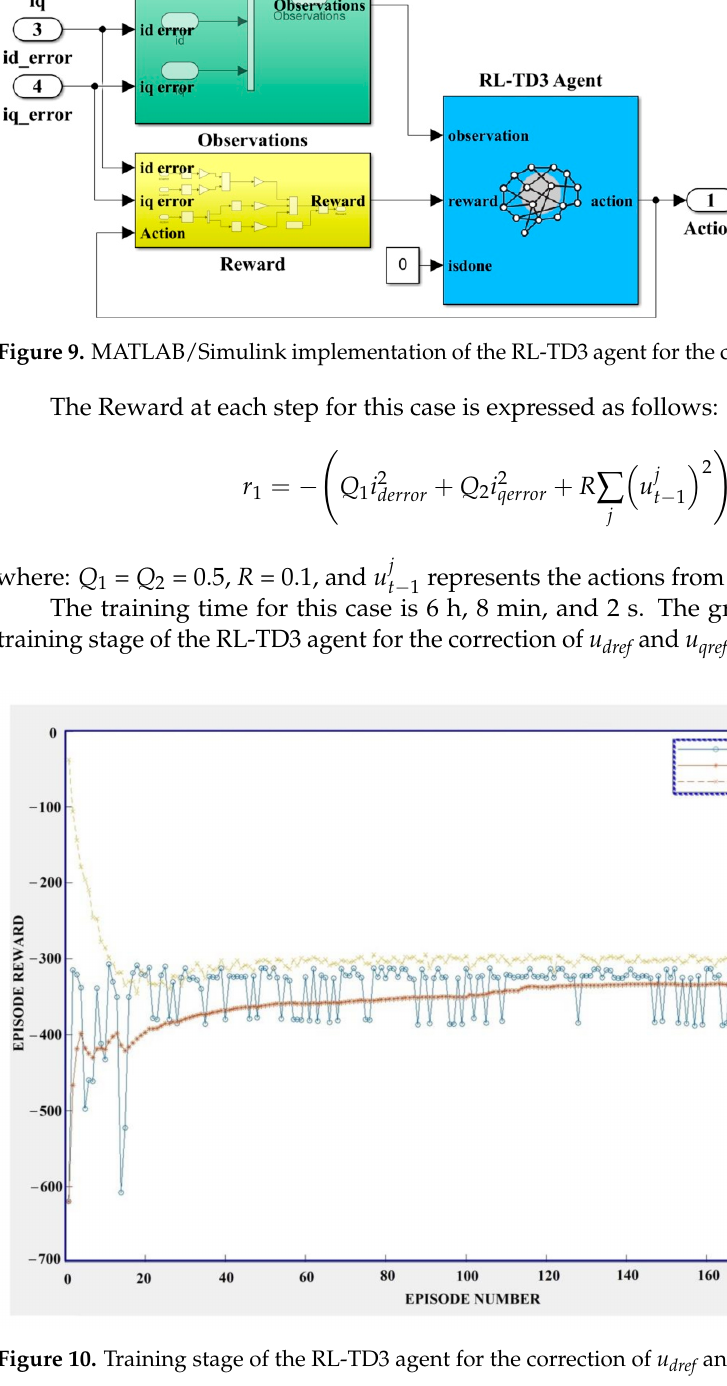
Figure 8. Block diagram of the MATLAB/Simulink implementation for the PMSM control based on